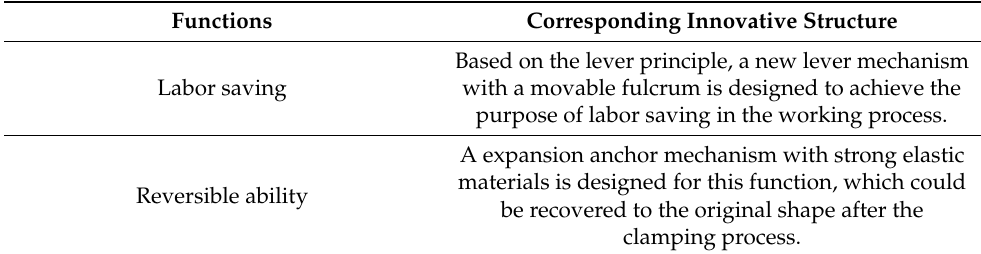
Table 1. Functions and corresponding innovative structures. Functions Corresponding Innovative